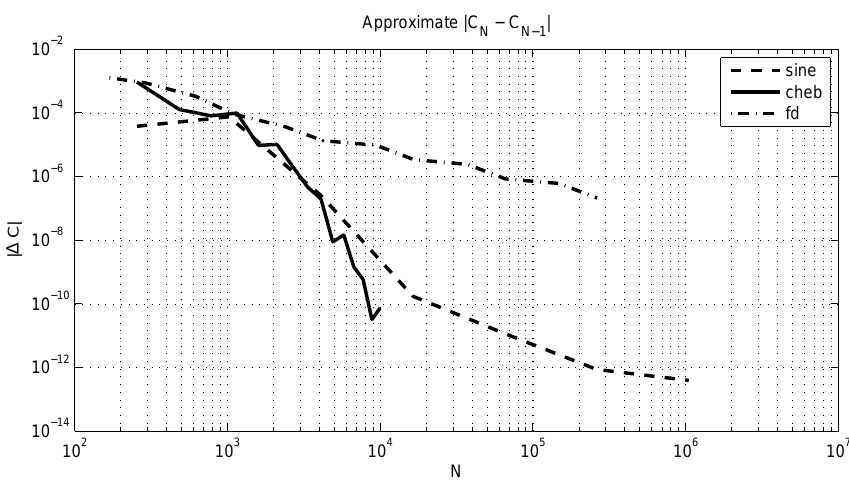
Fig. 1. The change in the predicted propagation speed as a function of degrees of freedom. Chebyshev pseudospectral method – solid, Fourier sine transform – dashed, Second order finite difference –